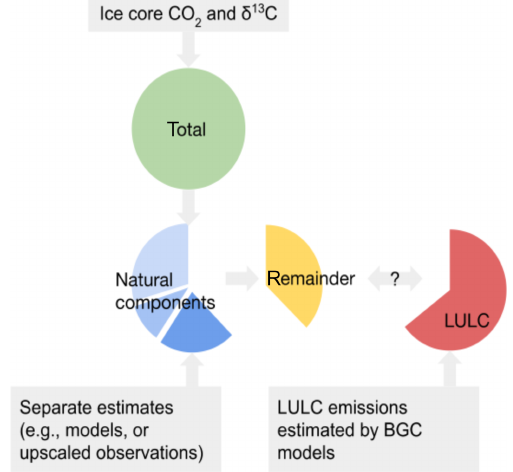
Figure 9. Illustration of the terrestrial C budget approach to eval- uate LULC. The total terrestrial C balance (green circle, “total”) is constrained by ice core records of CO 2 and its isotopic signa- ture ( δ 13 C). Estimates for C balance changes in different natural land carbon cycle components (e.g. peatlands, permafrost, forest expansion or retreat, desert greening) are estimated independently (blue slices, “natural components”) either from empirical upscal- ing of site-scale observations or from model-based analyses (car- bon cycle models forced with varying climate). The remainder (yel- low slice, “remainder”) is then calculated as the total terrestrial C balance (green circle, “total”) minus the sum of the separate estimates of the natural components (blue slices, “natural compo- nents”). The remainder is effectively the emissions resulting from LULC changes and can therefore be compared to LULC CO 2 emis- sion estimates by carbon cycle